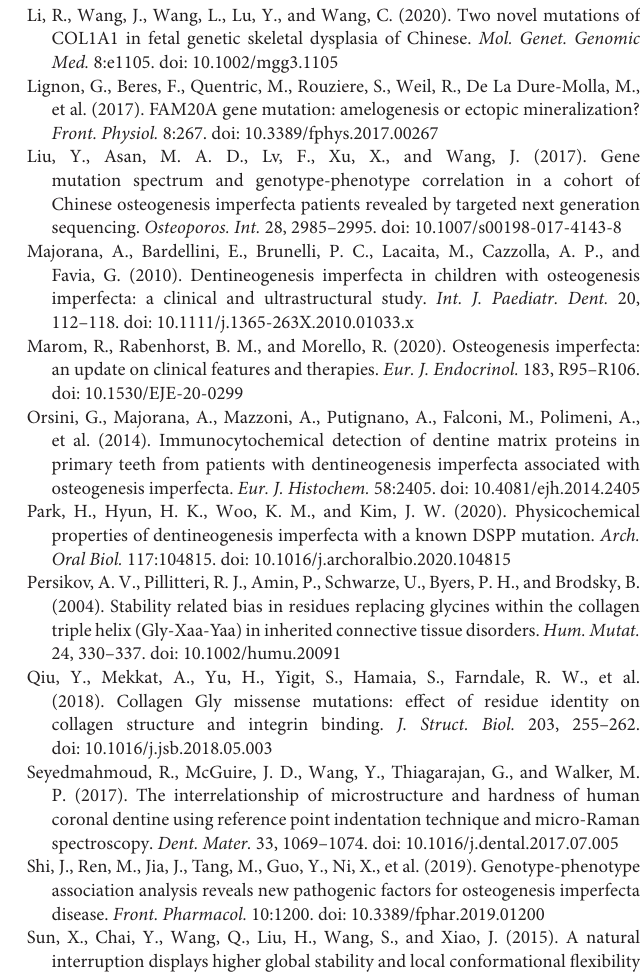
Supplementary Figure 1 | (A) Load-displacement curves of the tooth dentine. (B) Elemental composition of the normal and affected teeth. The levels of sodium (Na), magnesium (Mg), phosphorus (P) and calcium (Ca) are shown in separate graphs. (C) Hardness and modulus of the enamel and dentine of the normal and affected teeth ( ∗ P < 0.05 and ∗∗ P <